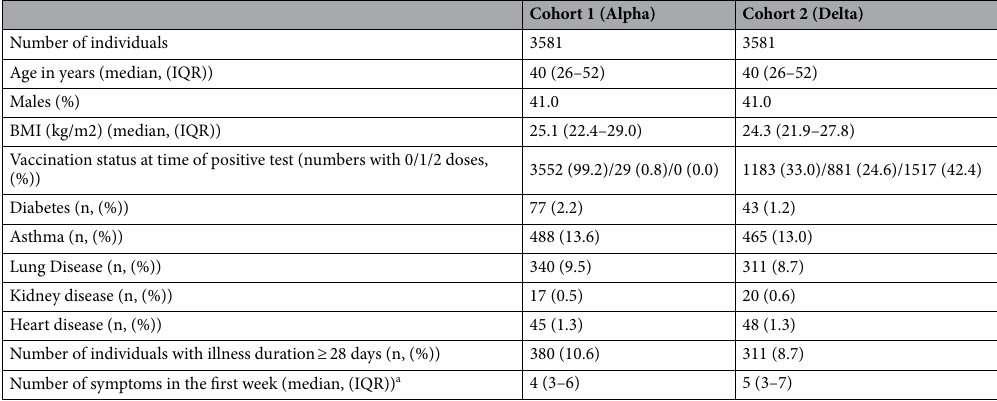
Table 1. Characteristics of UK individuals presenting with COVID-19, during periods of Alpha and Delta SARS-CoV-2 variant predominance. a Number of symptoms here considered from the 14 symptoms used in the analysis presented in Sudre et al. (viz.: fatigue, headache, dyspnoea, anosmia/dysosmia, persistent cough, sore throat, fever, myalgias, anorexia (‘skipped meals’), chest pain [otherwise undefined], diarrhoea, hoarse voice, abdominal pain and delirium) 17 .